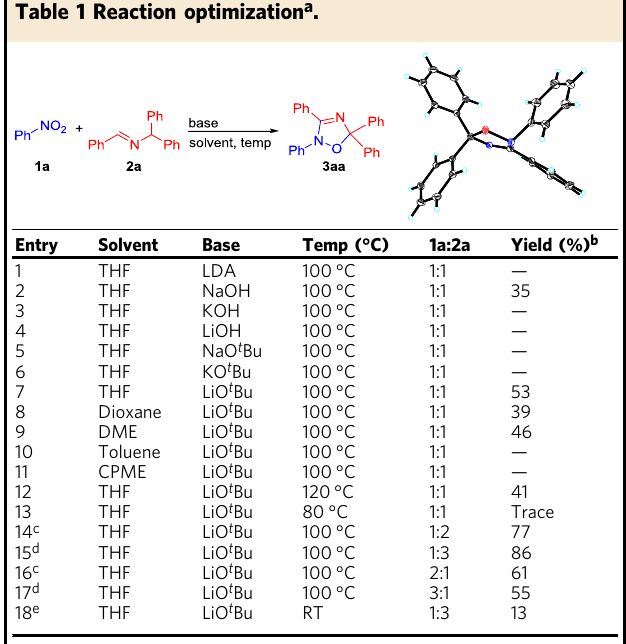
Table 1 Reaction optimization a .